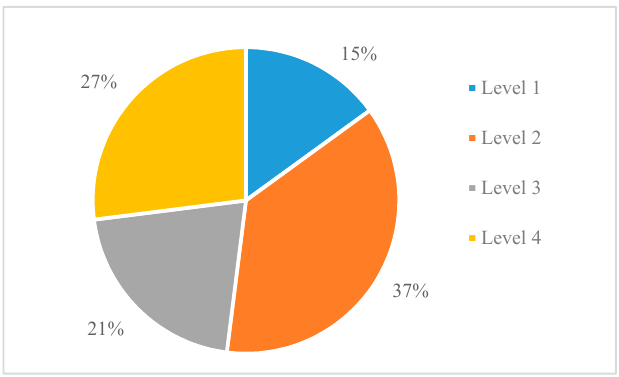
Figure 3. Percentage distribution of level for FLQ in China.